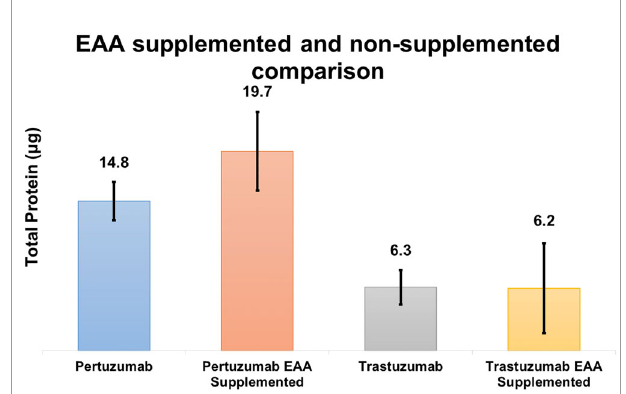
FIGURE 7 | Quanti fi cation comparison of transient recombinant antibody production between EAA spiked and non-spiked for POK PG1 and HOK HG1 constructs.